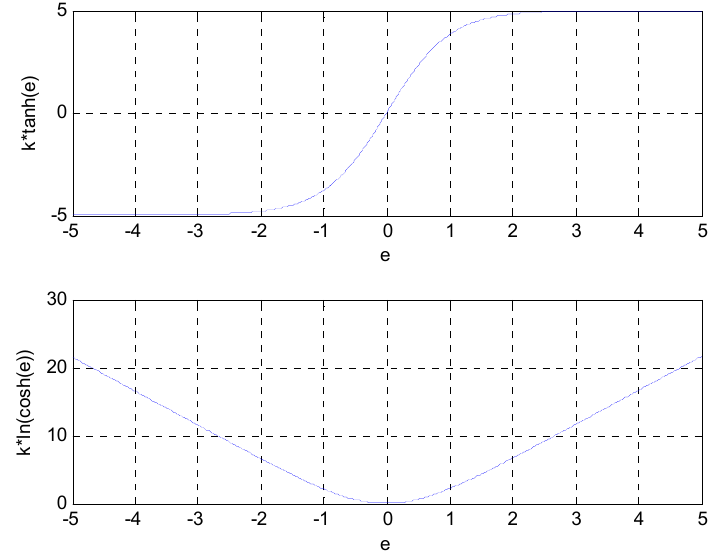
Figure 16. Hyperbolic tangent function and its derivative in error e i